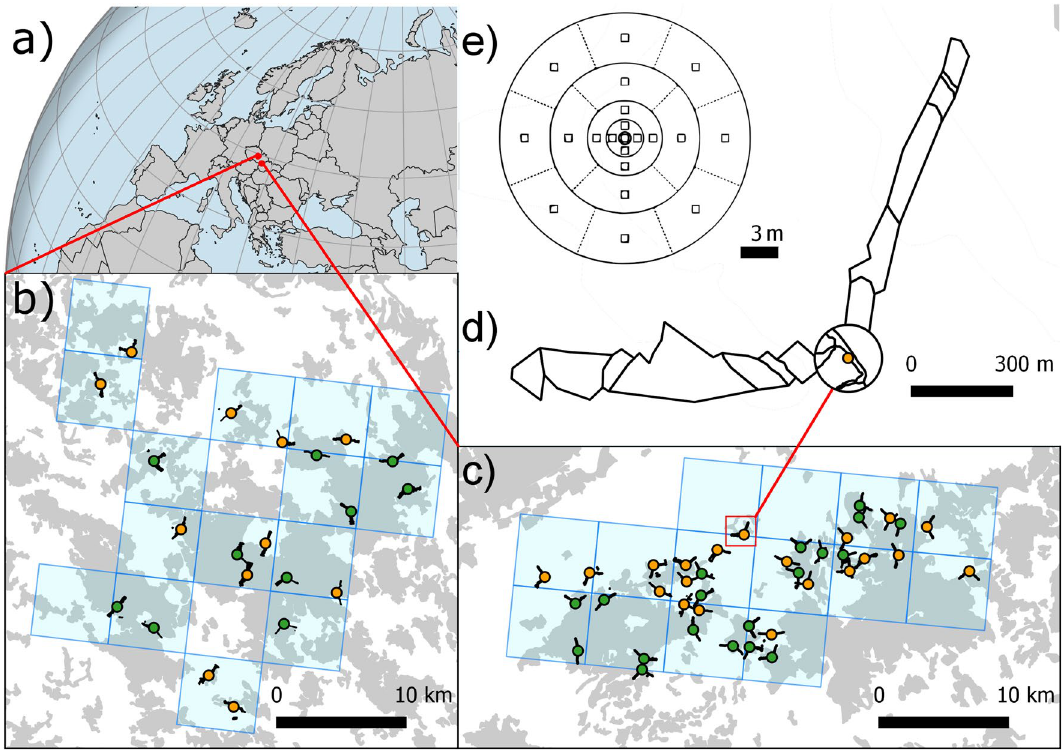
Figure 1. Map of the study areas showing ( a ) position within Europe, ( b ) BMH: Bohemian-Moravian Highlands, ( c ) WCM: White Carpathians. Yellow and green circles indicate sites in open habitats and forest, respectively. Blue squares show the area of the reference plant diversity data from the PLADIAS database. Grey indicates forested area. Short lines represent transects of the vegetation survey, ( d ) circle 10–100 m and two transects of polygons recording the plant diversity 100–1000 m, ( e ) 21 plots within 0–10